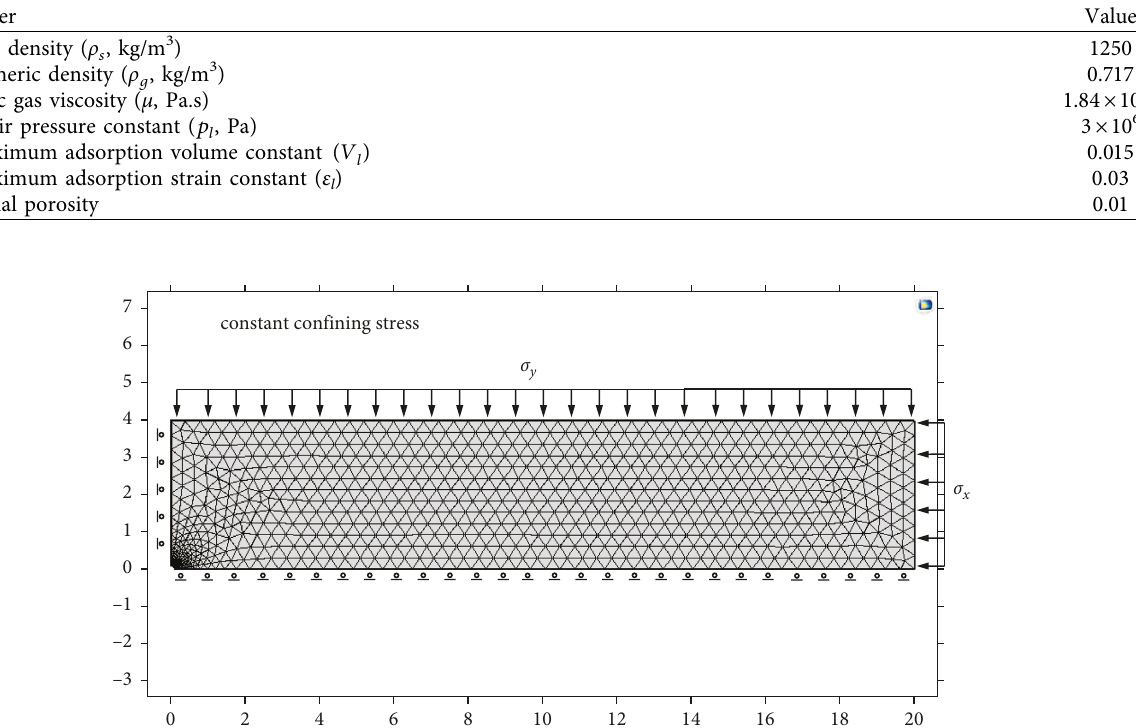
Figure 7: Illustration of the numerical model under constant stress